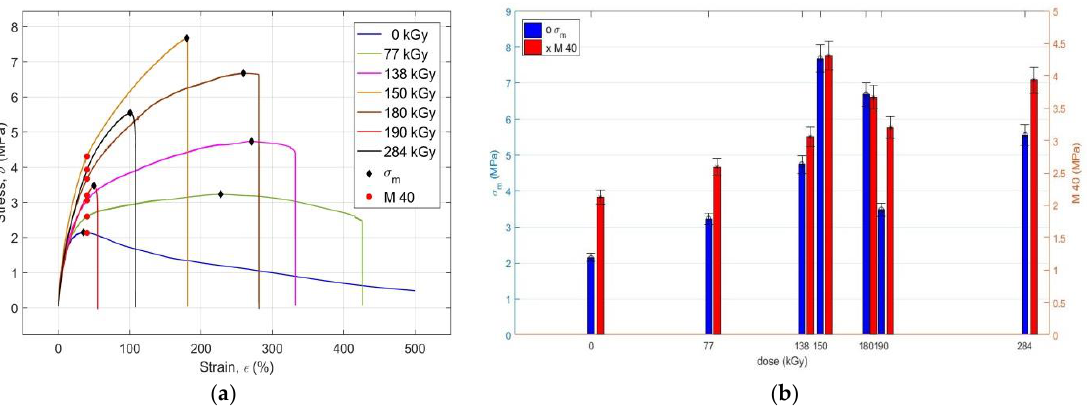
Figure 3. ( a ) Presentation of the strength limit values σ m and the modulus M 40 of the polymeric system PMX3 for the virgin sample and for the samples irradiated with different radiation doses; ( b ) Effect of the radiation dose on the strength limit values σ m and the modulus M 40 of the polymeric system PMX3.